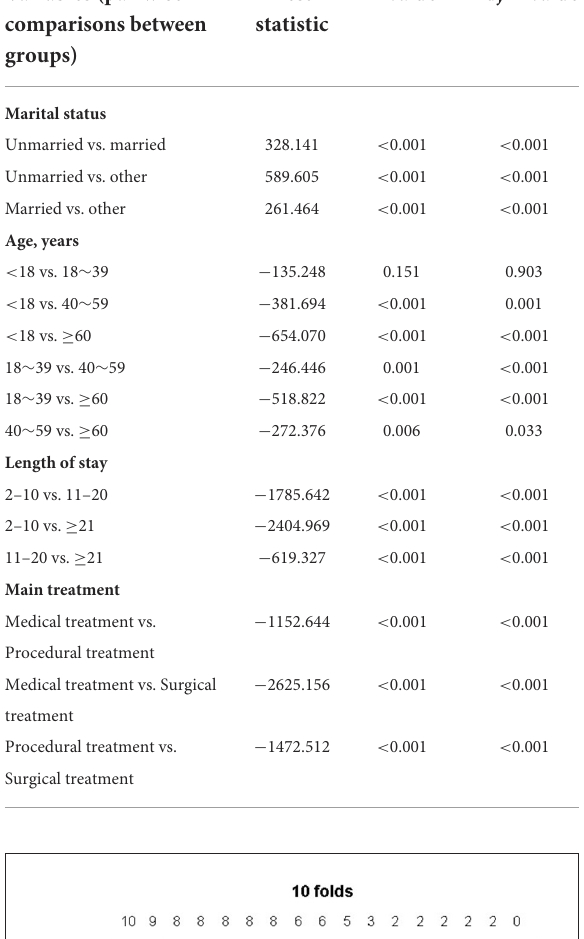
TABLE 2 Significance results of pairwise comparison.